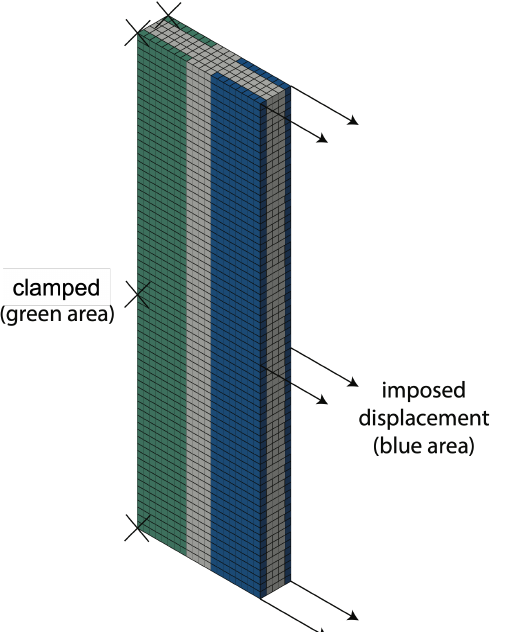
Figure 5. Boundary conditions and displacement imposed to the mesh to conduct FEM simulations. The FEM model mimics the experimental